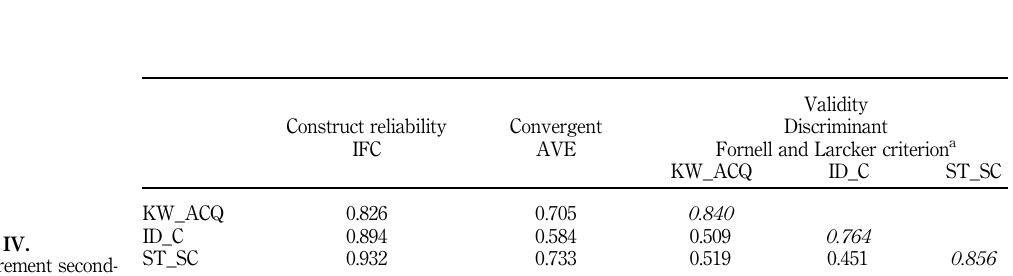
Table IV. Measurement second- order model